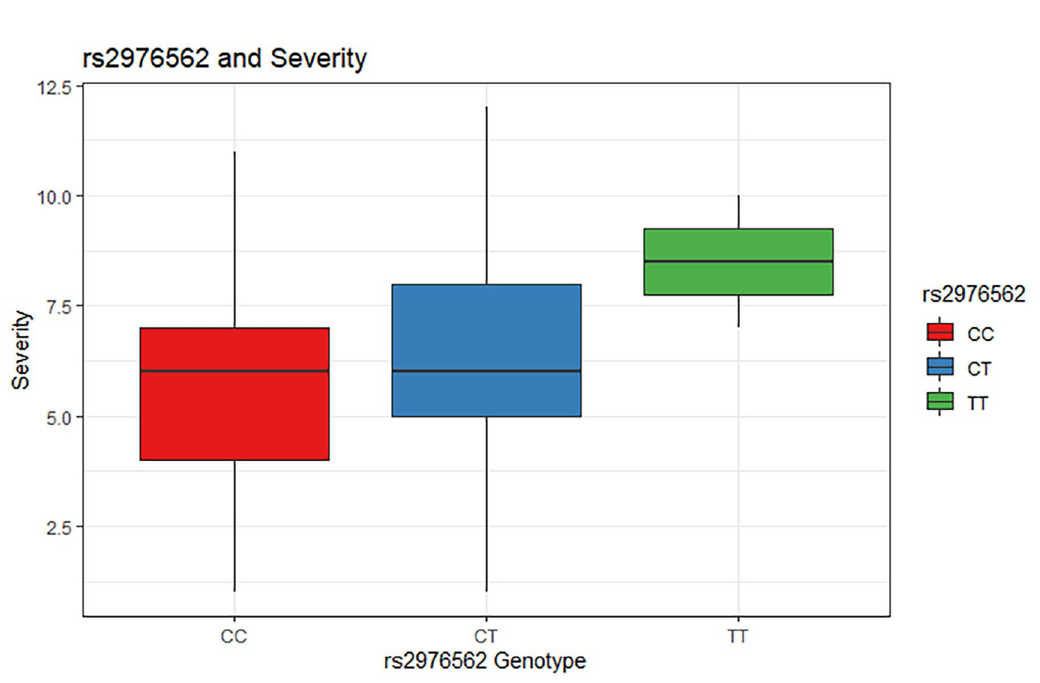
Fig 7. Relationship between rs2976562 alleles and TBscore (severity). Distribution of TBscore by